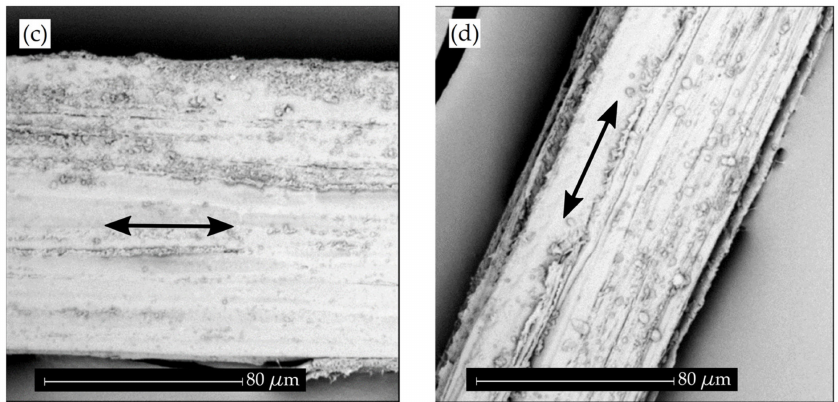
Figure 5. SEM images at 1500 × longitudinal PO fibres subjected to different chemical treatments, ( a ) untreated; ( b ) NaOH; ( c ) NaOH + APTMS and ( d ) NaOH + GLYMO (black arrows indicate the fibre